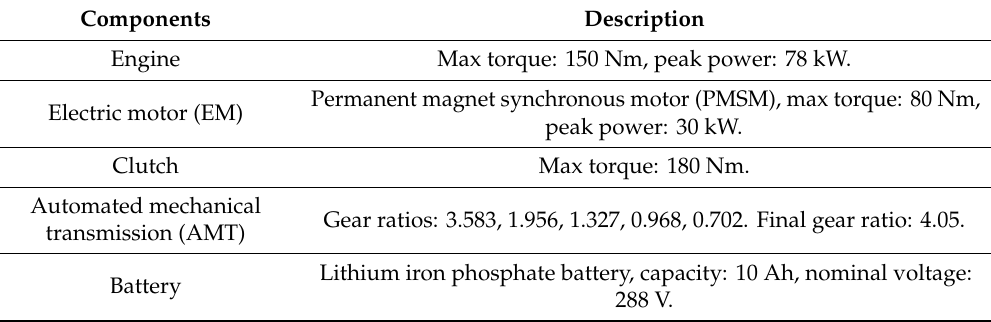
Figure 1. Structure of single-shaft parallel hybrid powertrain. Table 1. Main parameters of single-shaft parallel hybrid vehicle.